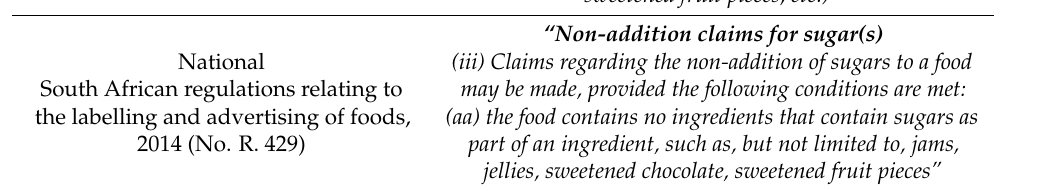
Table 5. Codex wording compared with South African regulations on labelling and advertising of foodstuffs. Source Textual quote